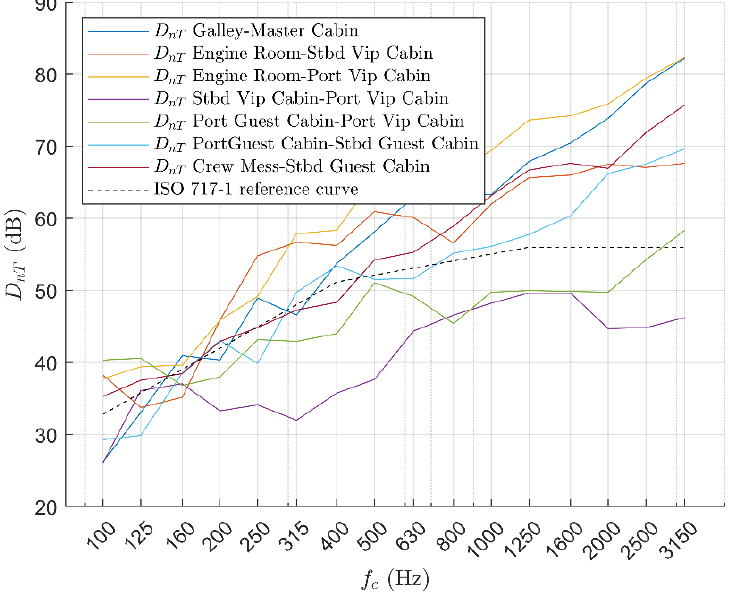
of the analyzed partitions and reference values 𝐷𝐷 𝑛𝑛𝑛𝑛